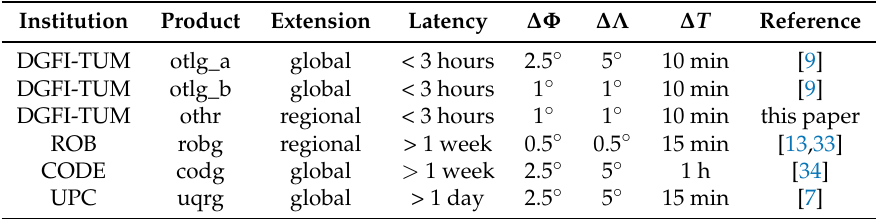
Table 3. Products used for validation; names, types and latencies are taken from the references listed in the last